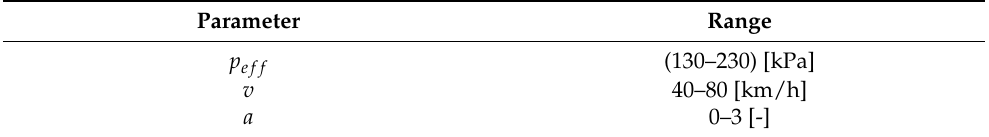
Table 4. Scenario parameters